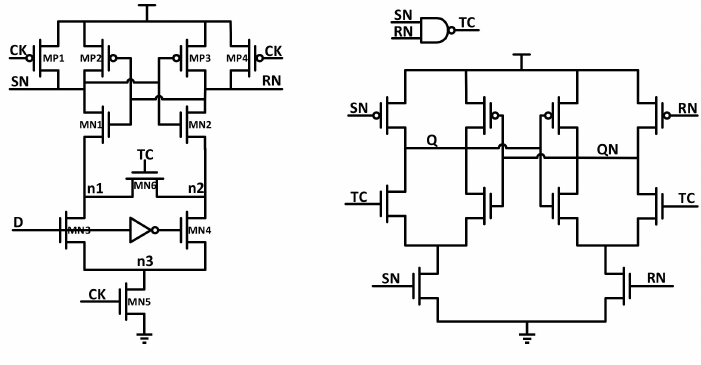
Figure 4. Schematic of Jeong’s SAFF.